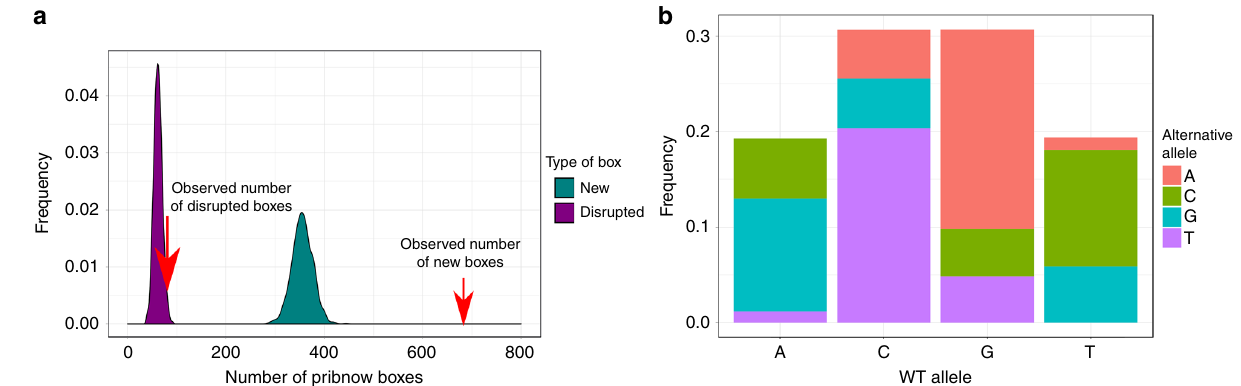
Fig. 3 Non-random processes impact the emergence and disruption of Pribnow boxes. a Distribution of new (green) and disrupted (purple) Pribnow boxes in 1000 random simulations. Red arrows mark the observed value for each type of event in our dataset. b Mutation bias towards new A and T alleles inferred from 235,212 substitution obtained from 4595 clinical samples of the MTBC and normalised by GC content as in ref.